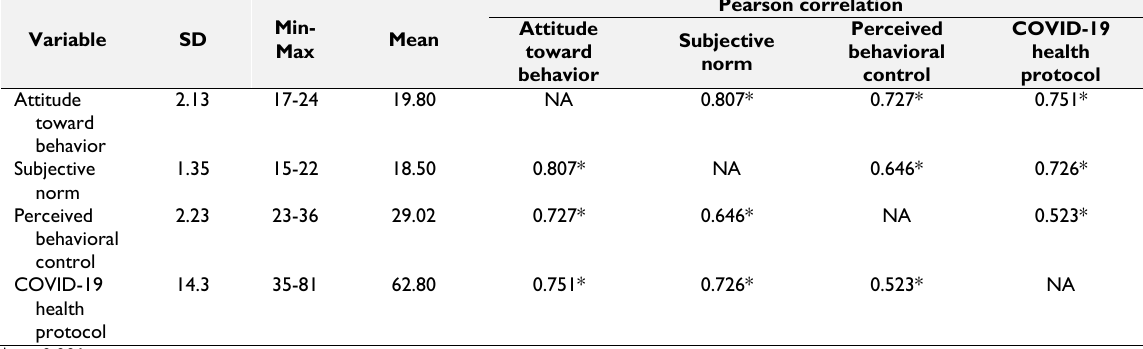
Table 3 SD, minimum and maximum value, mean and bivariate analysis among theory of planned behavior variable (N = 100)